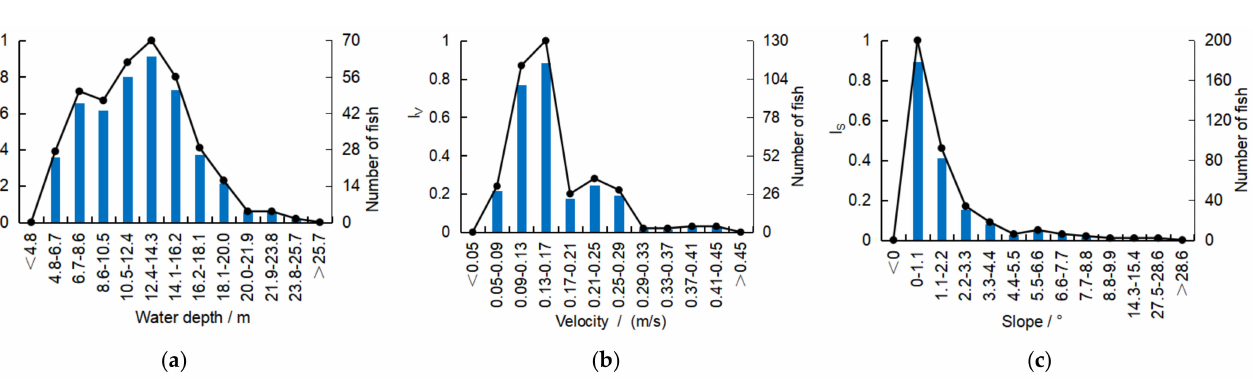
Figure 7. Habitat suitability histogram of water depth ( a ), velocity ( b ), topographic slope, and ( c ) distribution shown together with single-factor habitat suitability curves for migratory